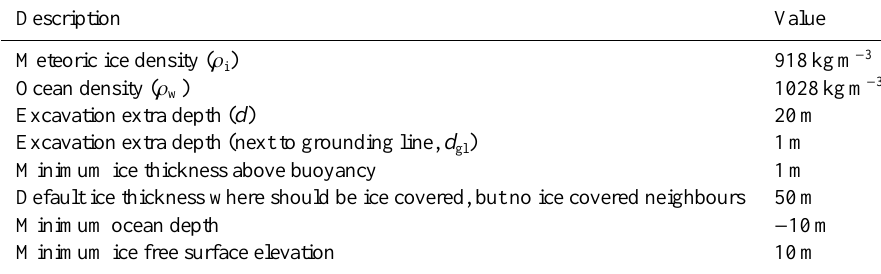
Table 3. Summary of values used in the